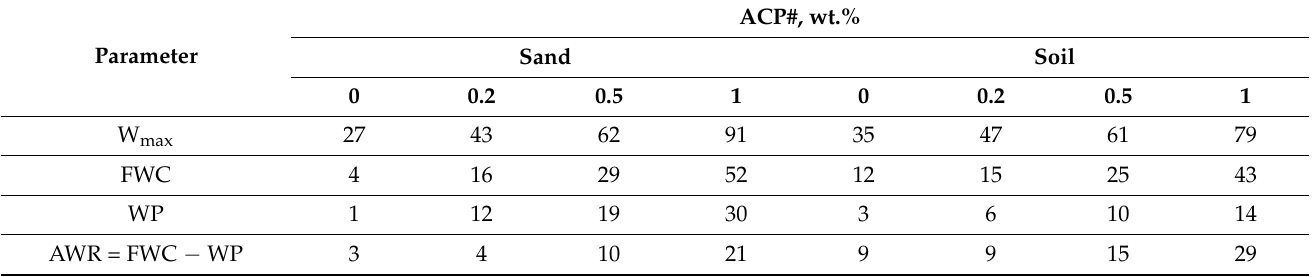
Table 2. Water retention characteristics of sand and soil before and after the introduction of the